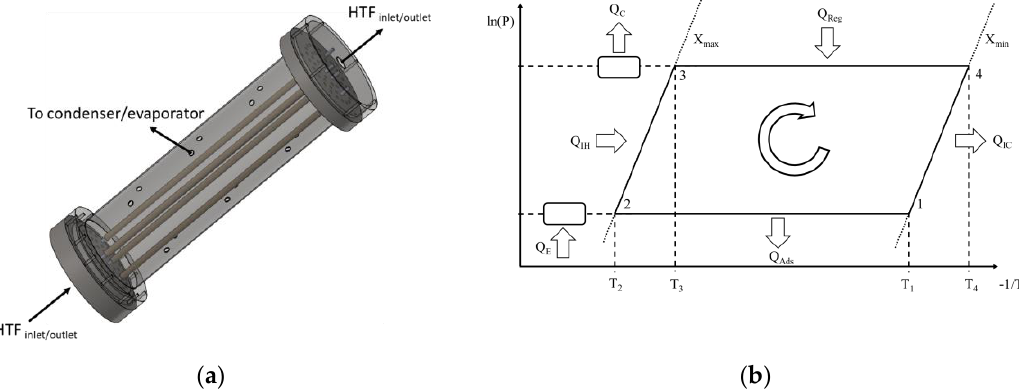
Figure 1. ( a ) Coated tube adsorber schematics; ( b ) Ideal thermodynamic cycle of the AHP (Adapted from [26] with permission from Elsevier).